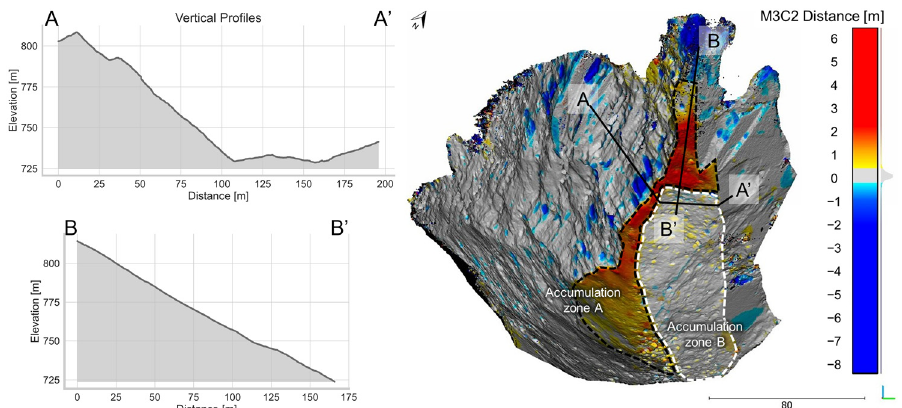
Figure 14. Three-dimensional change detection of UAV-based point clouds in highlighted accumu- lation zones A and B ( right side ). Orthogonal vertical profiles showing the morphology of the slope ( left side ).